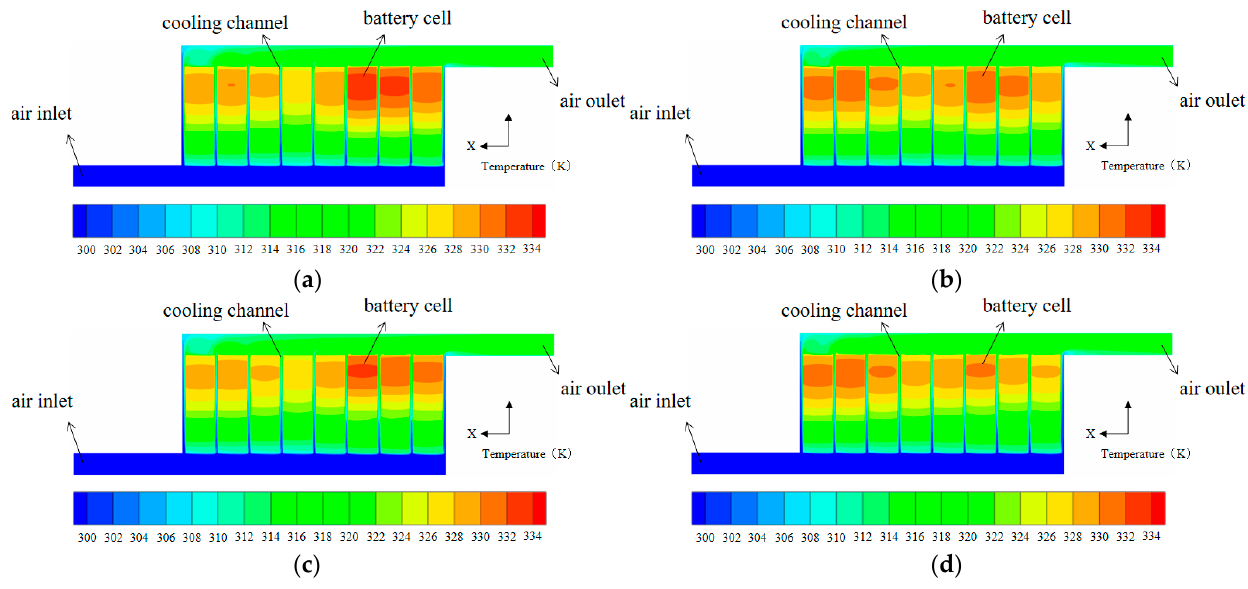
Figure 14. Temperature contours of four cases; ( a ) case4; ( b ) case4-opt1; ( c ) case4-opt2; ( d ) case4-opt3. For those optimal and basic systems, the calculation results about T max and Δ T max of the battery pack under various inlet airflow velocities are shown in Figure 15. As can be seen in Figure 15, as the inlet airflow velocity increased, T max of all cases had a certain degree of reduction, but ∆ T max was not sensitive and stayed relatively stable. The best cooling efficiency was obtained by case4-opt3 at different inlet airflow velocities. Hence, the above conclusions can be applied to other situations effectively.